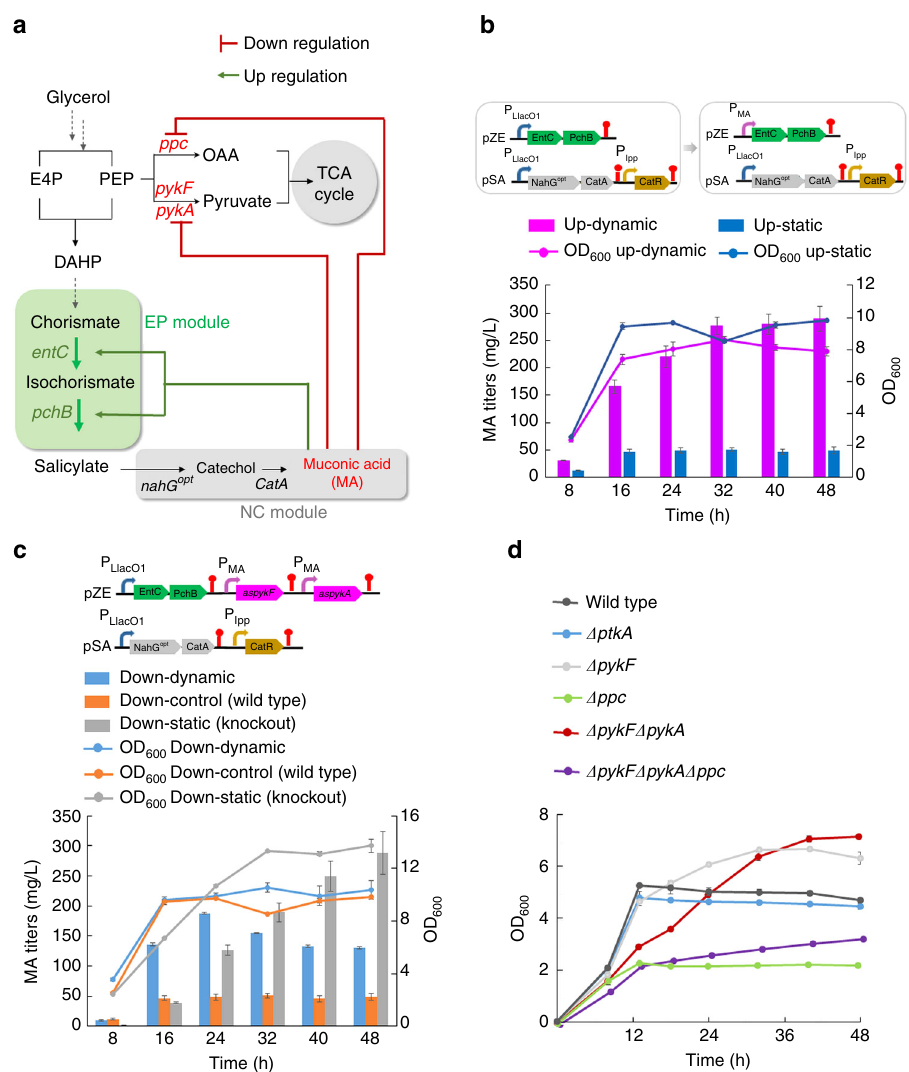
Fig. 2 Implementation of dynamic control for MA production in wild-type E. coli BW25113/F ′ . a The MA biosynthesis pathway is divided into two modules: EP module (green panel) responsible for salicylate (SA) biosynthesis by EntC and PchB, and NC module (gray panel) responsible for conversion of SA to MA by NahG opt and CatA. PEP fl ows into the tricarboxylic acid (TCA) cycle mainly through two pathways: phosphoenolpyruvate carboxylase ( ppc )- mediated carboxylation to OAA and pyruvate kinases ( pykA and pykF ) mediated conversion to pyruvate. The designed dynamic control network follows the logic that the end product MA serves as the inducer to turn on the EP module and turn down the carbon fl ux into TCA cycle via RNAi. b MA production behavior by dynamically upregulating EP module. Up-dynamic: P MA -controlled expression of EP module (P MA -EP, BW25113/F ′ ); Up-static: leaky expression of P LlacO1 -controlled EP module (P LlacO1 -EP, BW25113/F ′ ). c MA production behavior by dynamically downregulating pykA and pykF . Down-dynamic: P MA - controlled expression of aspykF and aspykA (P LlacO1 -EP, P MA - aspykF , P MA - aspykA , BW25113/F ′ ); Down-control (Wild-Type): no control on gene pykA and pykF (P ′ ); Down-static (Knockout): pykF and pykA disruption (P ′ Δ pykF Δ pykA ). d Growth curve of E. coli knockout LlacO1 -EP, BW25113/F LlacO1 -EP, BW25113/F strains with individual or combinatorial deletion of genes pykA , pykF , and ppc . All the above data from the static group (control) were generated from three biological replicates, all the data from dynamic group were generated from fi ve biological replicates, and error bars represent